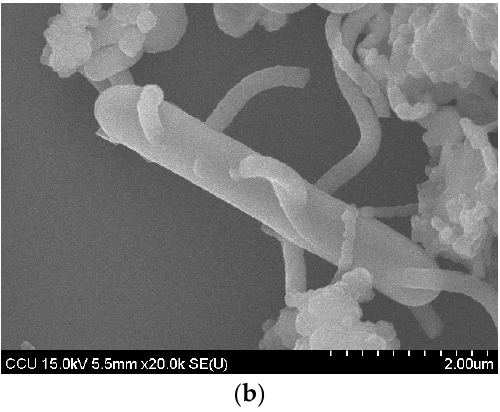
Figure 10. ( a ) Transmission electron microscopy (TEM) of bacterial cell wall-like HCNiO; and ( b ) Figure Scanning electron microscope ( S EM) of bacteria-templated HCNiO.